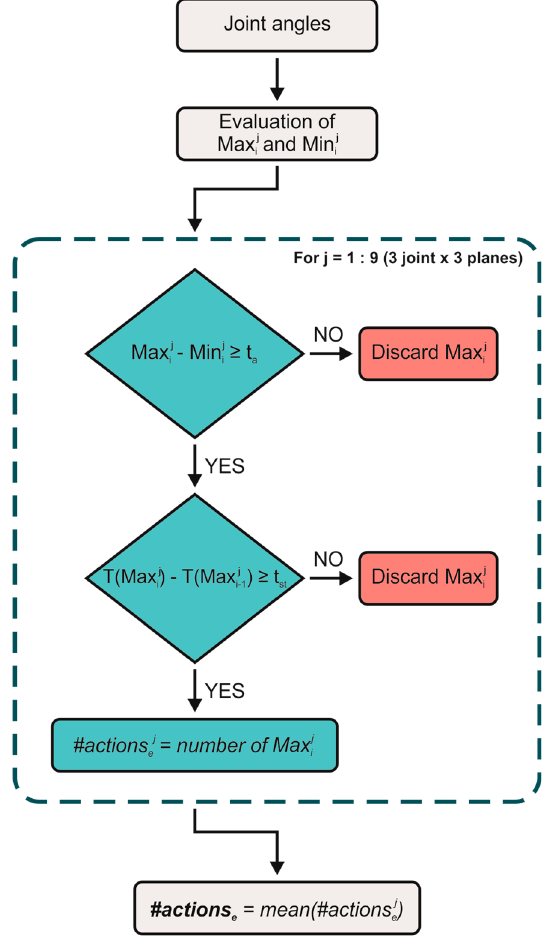
Figure 2. Flowchart of the threshold-based (TB)-procedure.